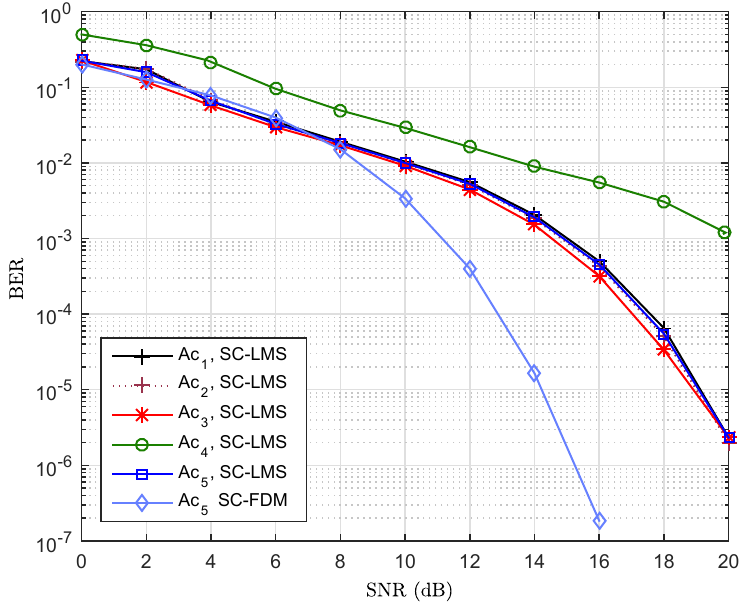
Figure 15. BER vs. SNR comparison of the proposed OFDM and SC-FDM communication system for the A c with N p = 16, FFT = 256 and BW = 200 kHz. Configurations cover 64 QAM SC-FDM, 64 5 and 32 QAM conventional OFDM.